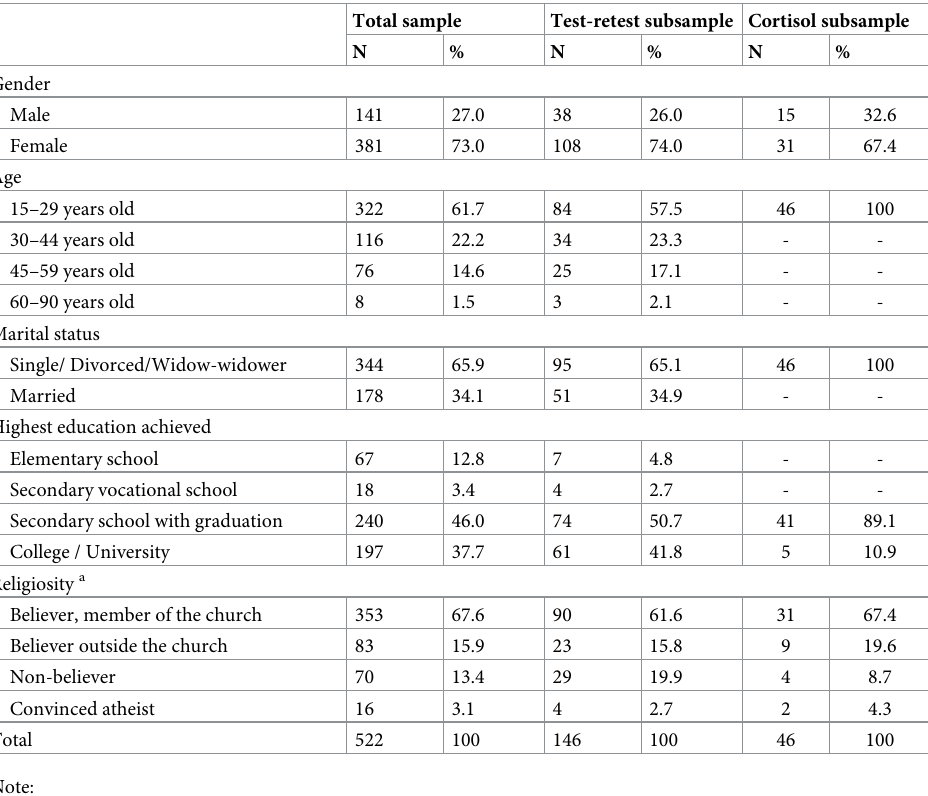
Table 2. Description of the study